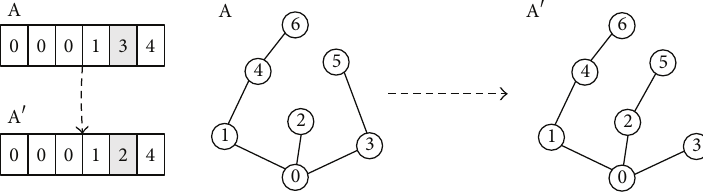
Figure 4: An example of mutation, where the 5th gene is selected to perform mutation [9].